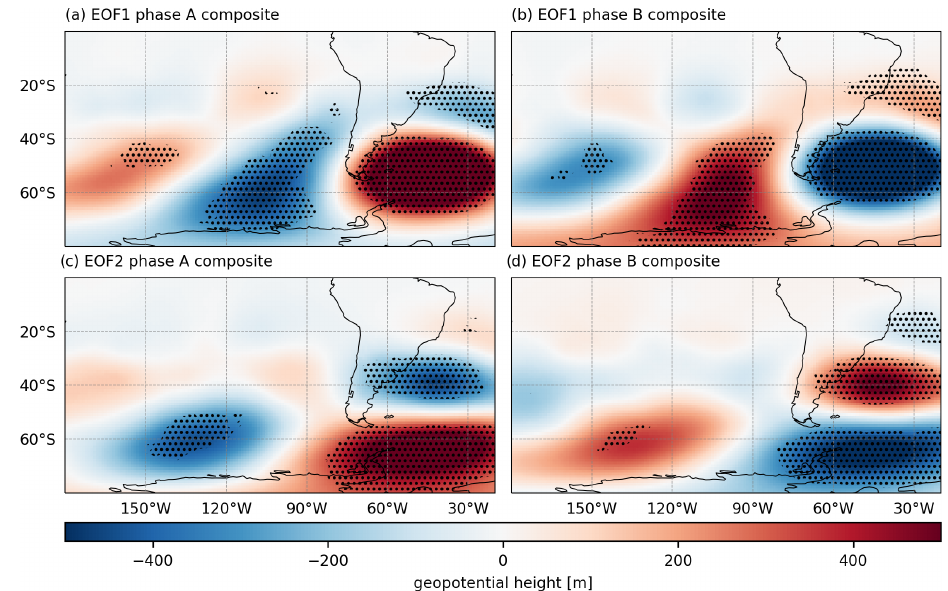
Figure 10. Composite of the geopotential height anomaly at 200hPa (shaded) for the u 10 EOF1 in phase (a) A and (b) B, as well as EOF2 in phase (c) A and (d) B. Black dots denote where the signal is significant within the 95% confidence level.